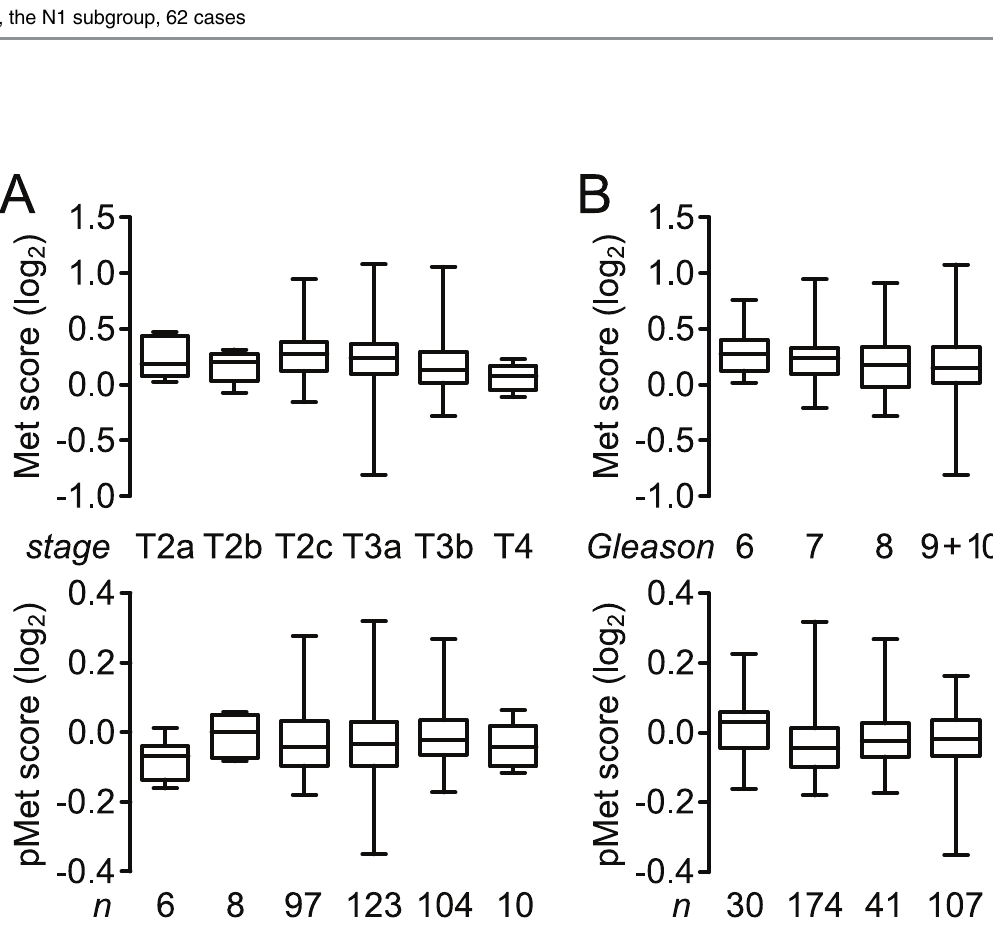
Fig 2. A. Box and whisker plots of Met (upper panel) and pMet content (lower panel; RPPA score, log 2 ) across clinical T stage subgroups of primary prostate adenocarcinoma biopsies that were obtained as part of the PRAD TCGA Provisional data set. A statistically significant inverse correlation between Met content and higher T stage was found (Table 3). B. Box and whisker plots of Met (upper panel) and pMet content (lower panel; RPPA score, log 2 ) across clinical Gleason score subgroups of primary prostate adenocarcinoma biopsies that were obtained as part of the PRAD TCGA Provisional data set. A statistically significant inverse correlation between Met content and higher Gleason score was found (Table